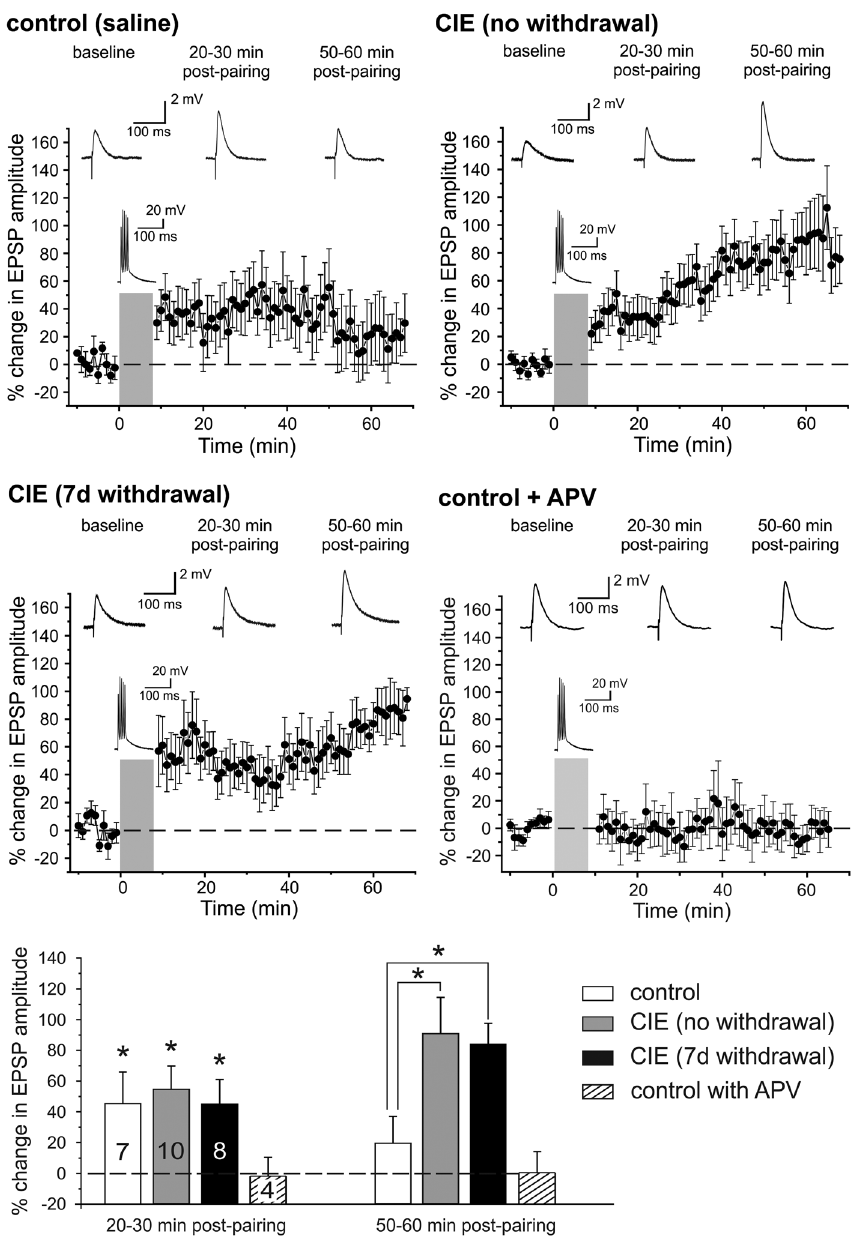
Figure 4. Chronic intermittent ethanol (CIE) exposure alters the time course of STDP. EPSPs were induced by focal stimulation close to basal dendrites of the recorded neuron in layers V/VI. Pairing an EPSP with a burst of postsynaptic action potentials lead to consistent increases in all 3 treatment groups (control, CIE no withdrawal, and CIE followed by 7 days of withdrawal) at 20–30 minutes post pairing. However, at 50–60 minutes post-pairing the EPSP amplitude in CIE exposed mice was significantly increased relative to controls in both the no-withdrawal and one-week withdrawal group. Induction of STDP was NMDAR-dependent: In the presence of the NMDAR antagonist APV the burst of postsynaptic action potentials did not result in a significant change from baseline in slices prepared from control animals. The bar graph shows the relative increase in EPSP amplitude relative to the 10 minutes baseline at 2 different time points (20–30 min and 50–60 min post STDP induction, respectively) for the 4 groups. At 20–30 min, the EPSP amplitude was significantly increased over baseline in all groups. The relative amount of LTP at 50–60 minutes post- pairing was significantly different between control and CIE mice. This was due both to a decrease in potentiation at the late time-point and to the continued increase in LTP in both CIE-exposed groups of mice. *p , 0.5 significantly different from baseline (20–30 min) or the vehicle control group (50–60 min), respectively (Repeated measures ANOVA and post-hoc analysis using unpaired Student’s t-tests). doi:10.1371/journal.pone.0037541.g004 more correct than incorrect choices over the course of training. to reach this criterion did not differ between groups (control The total number of trials to reach criterion and the number of errors made were both significantly higher in CIE mice when withdrawal, 1.6 6 0.25). A separate analysis conducted on the compared to controls (Figure 5B, C). The number of probe trials errors committed during the set-shift revealed a significant main